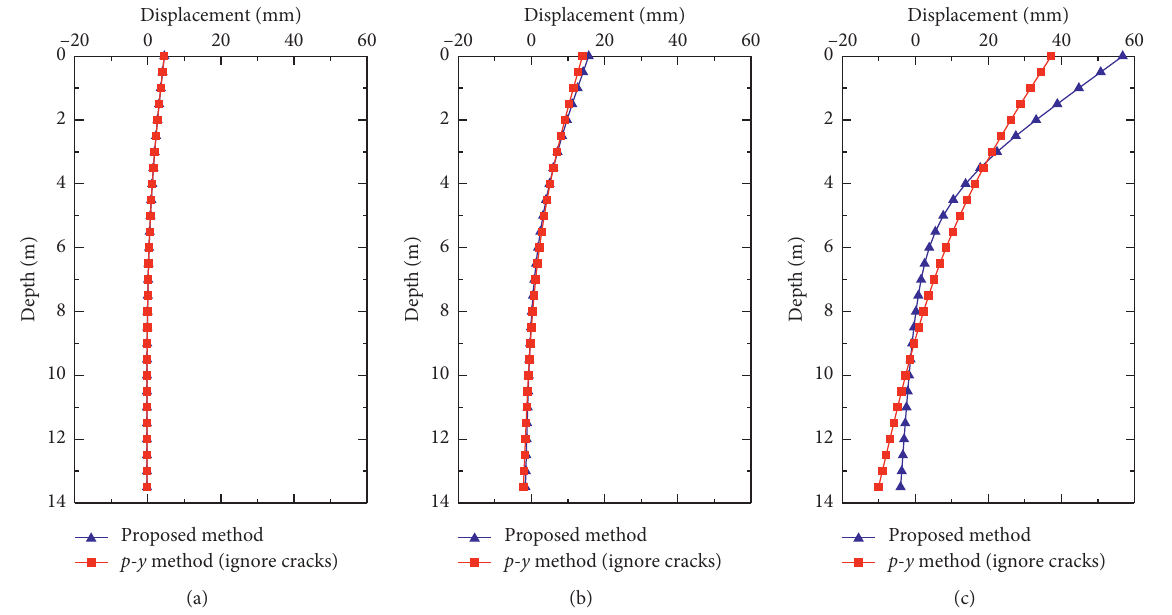
Figure 11: Influence of cracking on the pile displacement: (a) load � 150kN; (b) load � 270kN; (c) load � 420